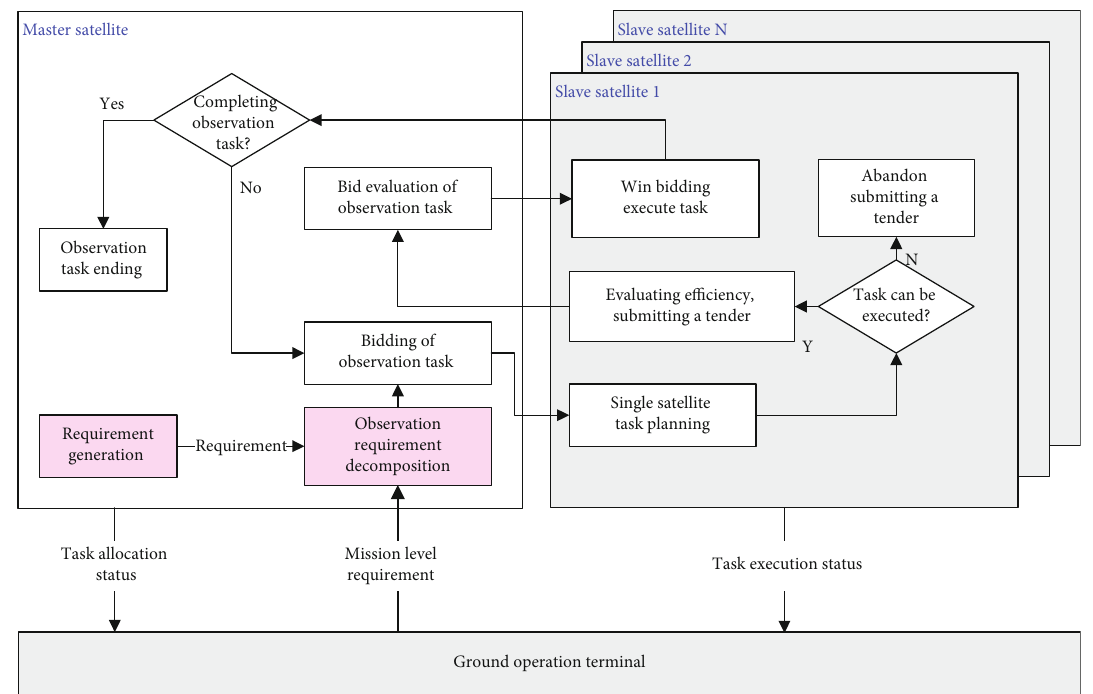
Figure 6: Swarm collaborative task allocation and planning